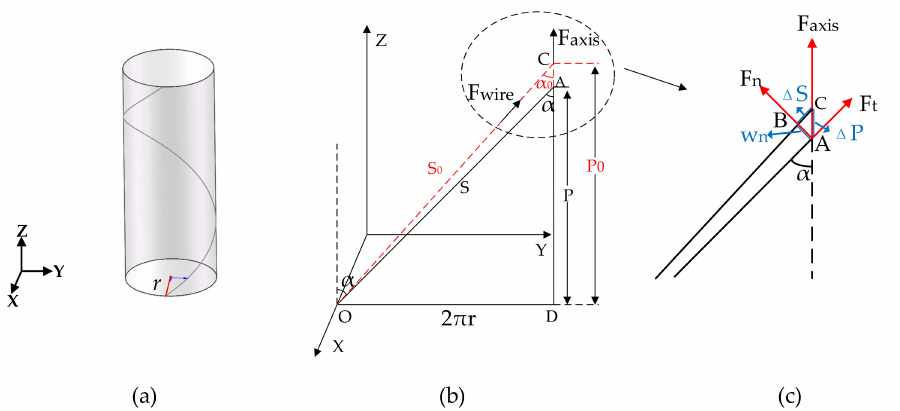
Figure 5. Force analysis of one wire: ( a ) Diagram of helix wire, ( b ) Diagram of unfolded wire, ( c ) Decomposition of